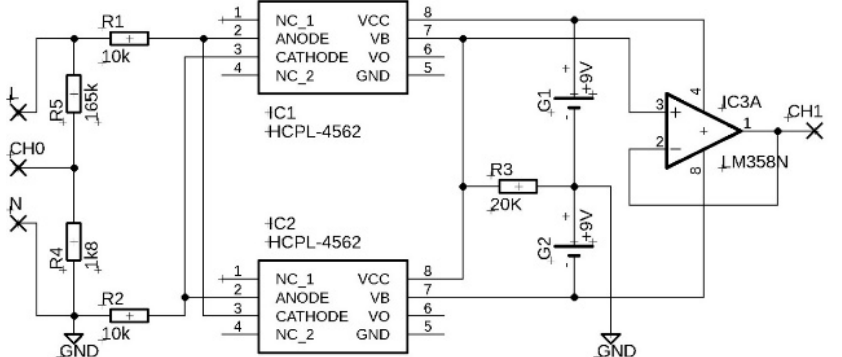
Figure 6. The wiring of the fixture with the optocouplers HCPL-4562. HCPL-4562 circuit pins: 1- not connected, 2-LED anode, 3-LED cathode, 4-not connected, 5-transistor emitter, 6-transistor collector, 7-transistor base and photodiode anode, 8-photodiode cathode.